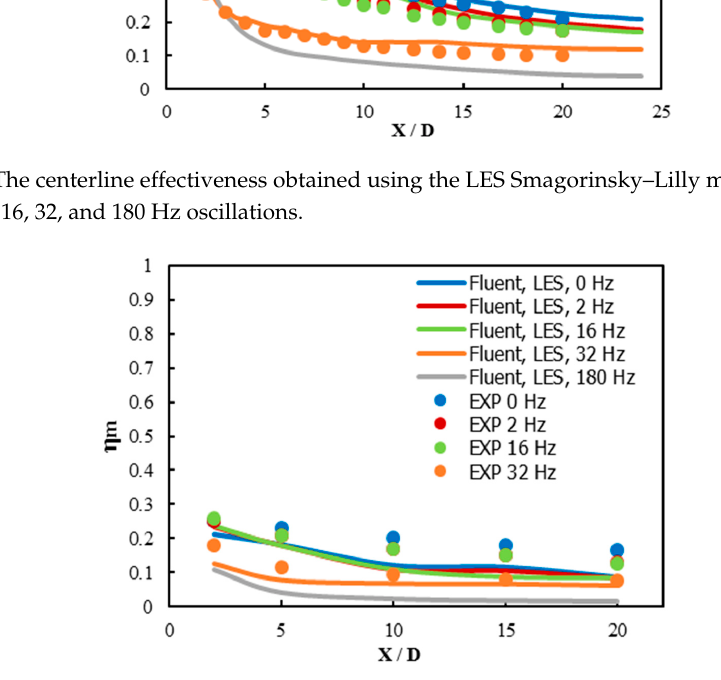
Figure 15. The spanwise-averaged effectiveness obtained using the LES Smagorinsky–Lilly model for M = 0.5 for the 0, 2, 16, 32, and 180 Hz oscillations.